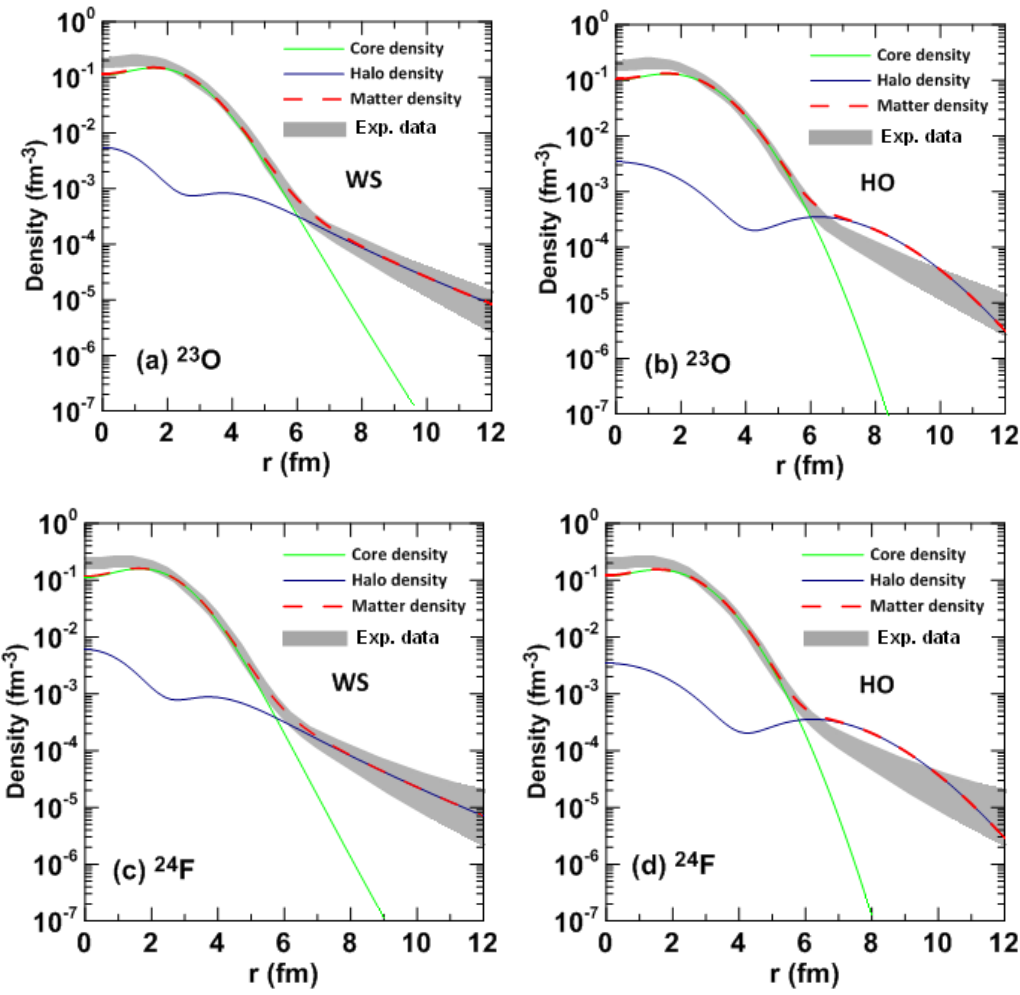
Fig.1: The matter, core and halo densities for halo nuclei 23 O and 24